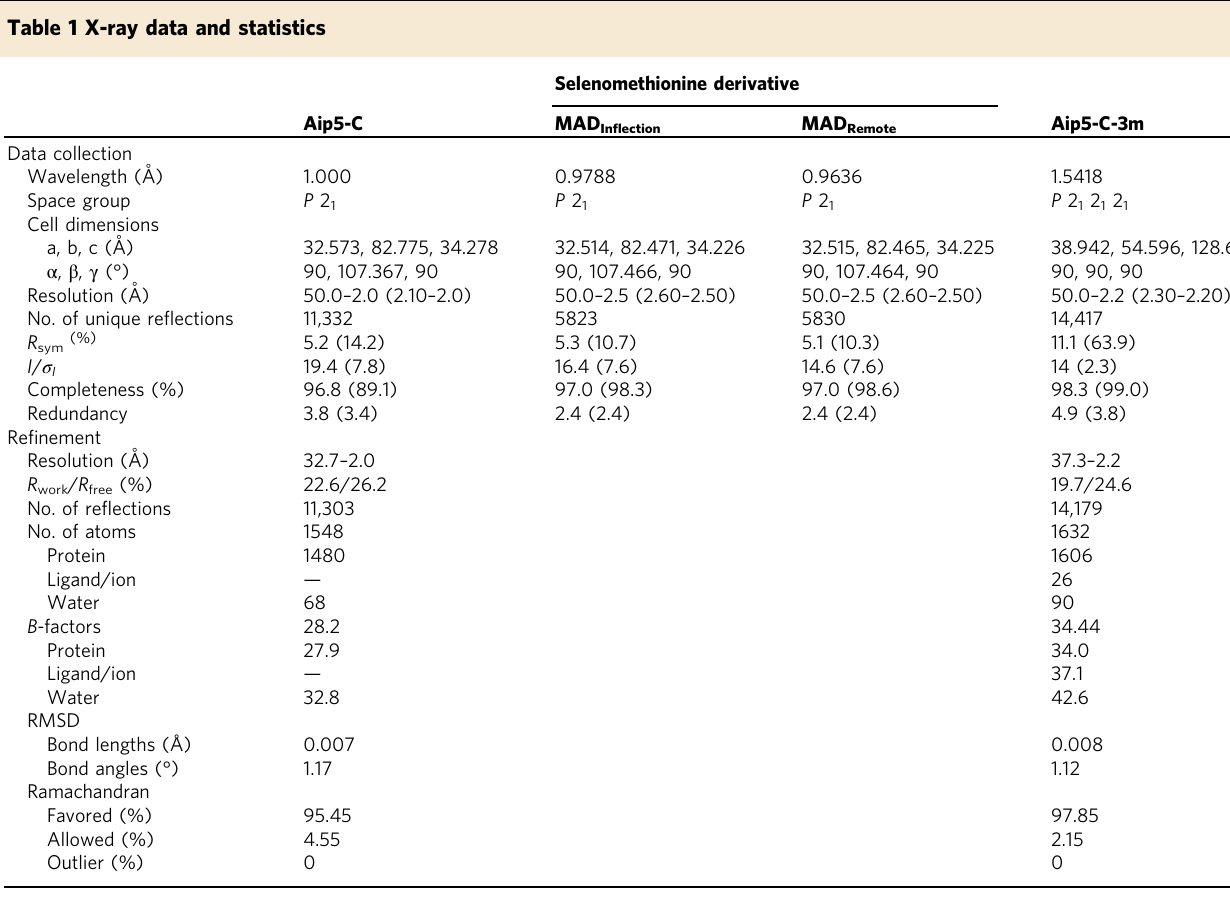
MAD diffraction data were collected from one crystal Values in parentheses are for the highest-resolution